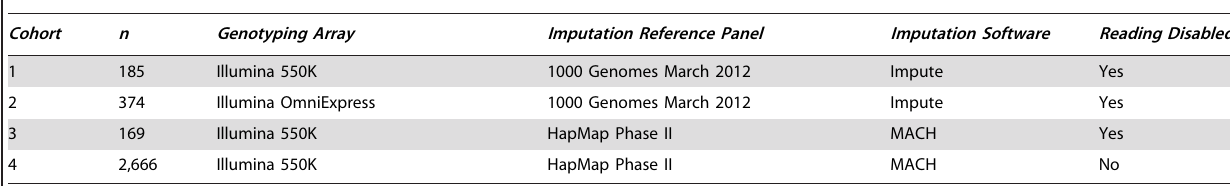
Table 1. GWAS study design.